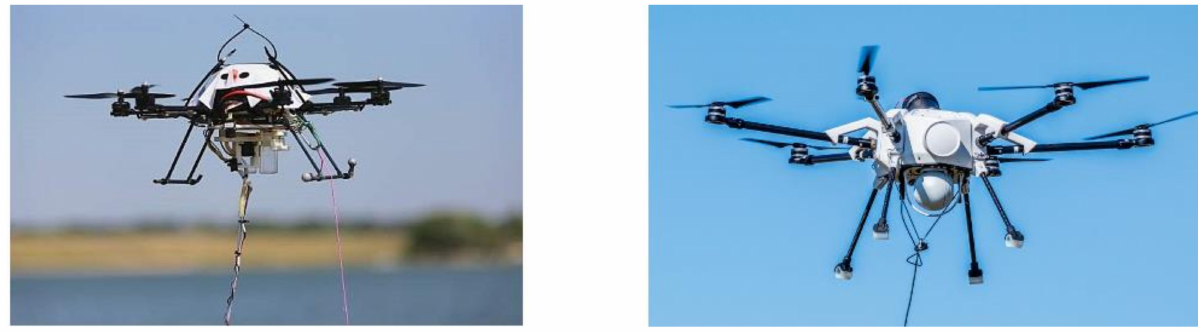
Figure 6. Tethered UAVs